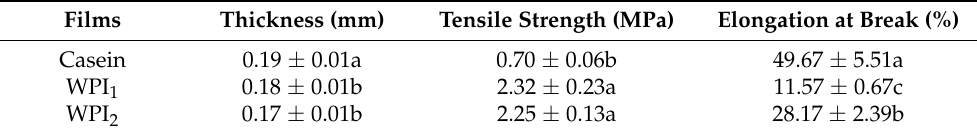
Table 1. Thickness and mechanical properties of milk protein-based edible films 1 .